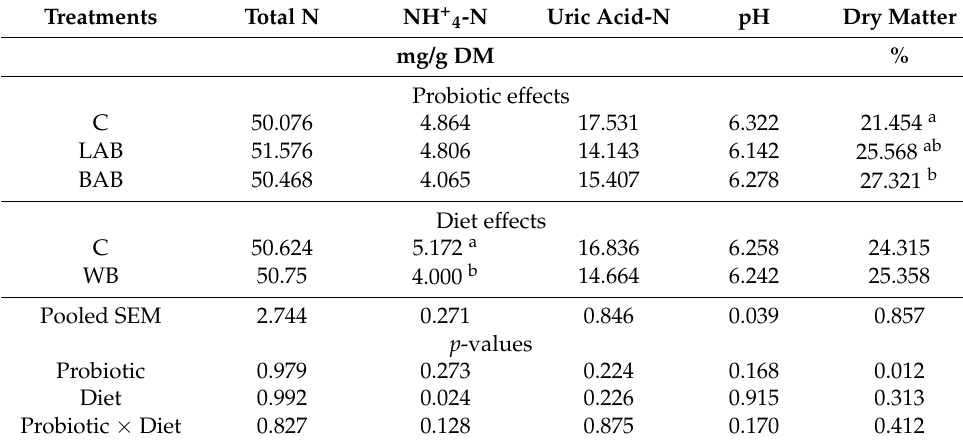
Table 3. Composition and pH of excreta